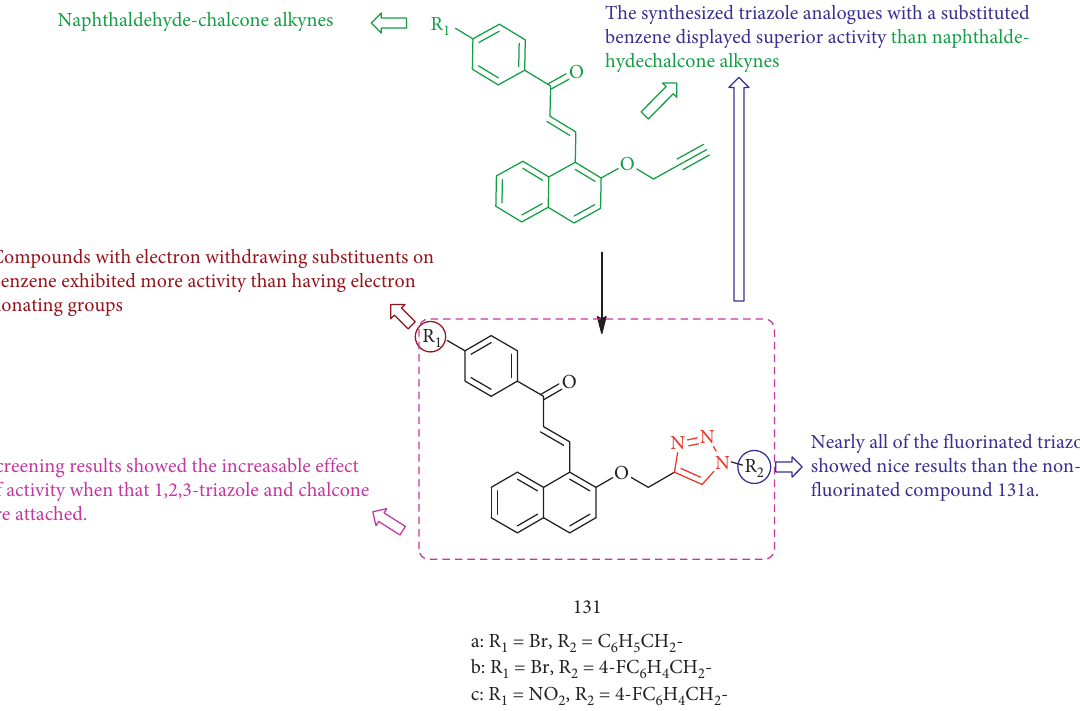
Figure 66: Chemical structure of chalcone-1,2,3-triazole